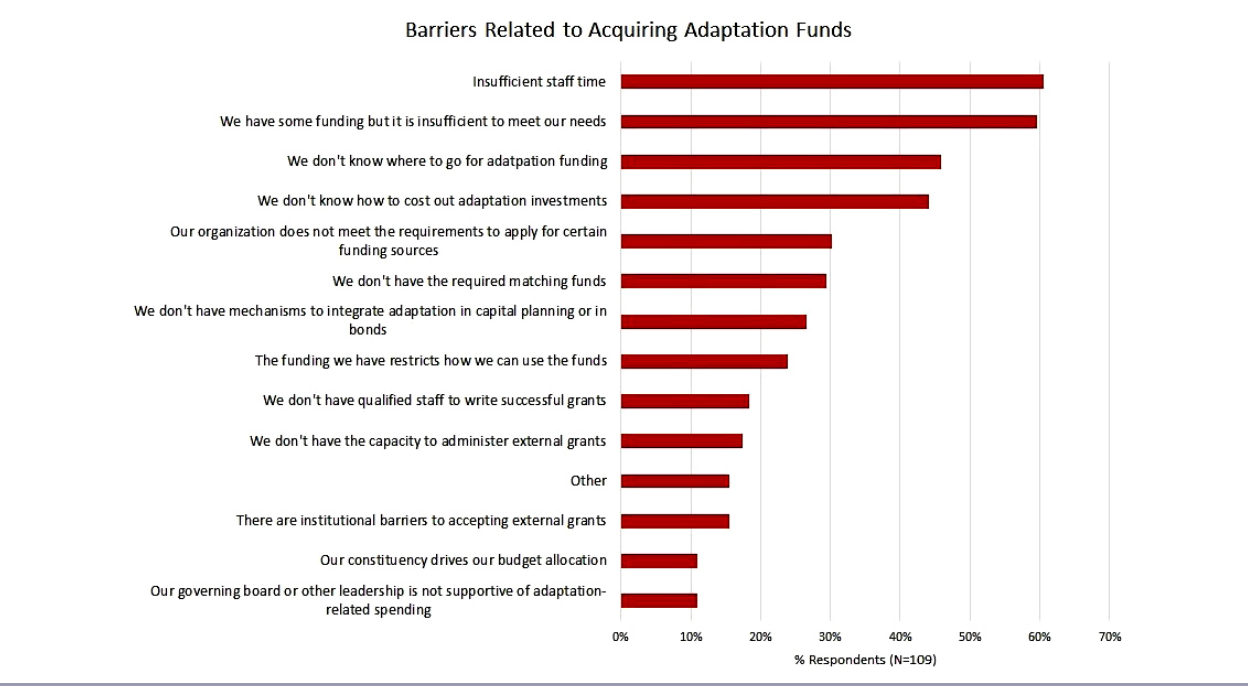
Fig. 1 . Barriers specifically related to acquiring adaptation